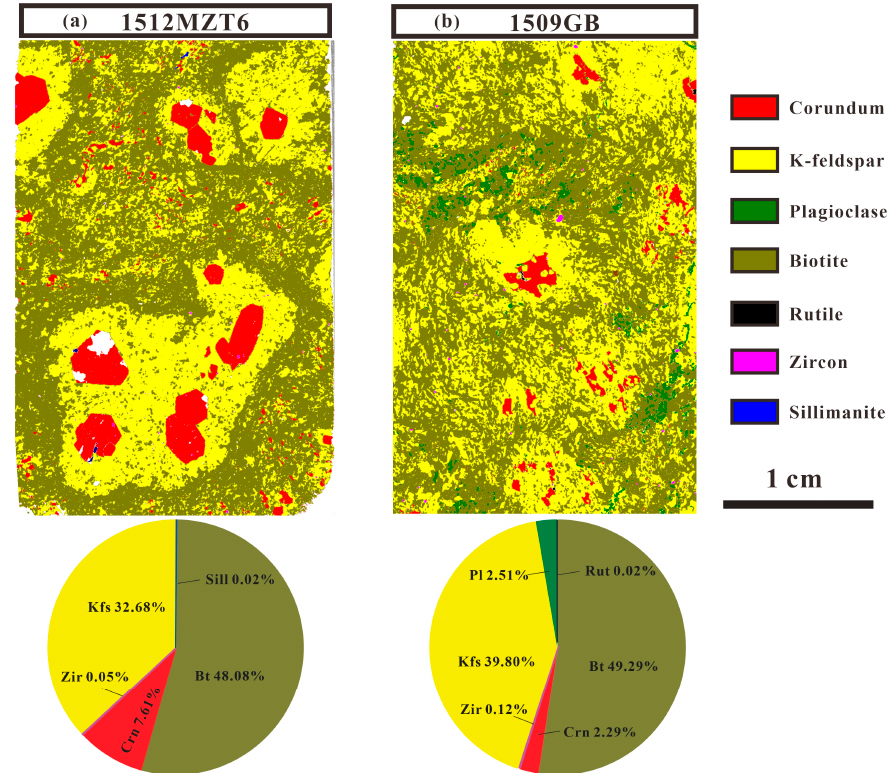
Figure 3. Major element μ -XRF maps of whole thin sections of the studied samples 1512MZT6 ( a ) and 1509GB ( b ). The legend shows the mineral proportions in each sample. White zones are holes through which the thin section glass was analyzed. Minerals 2020 , 10 , 213